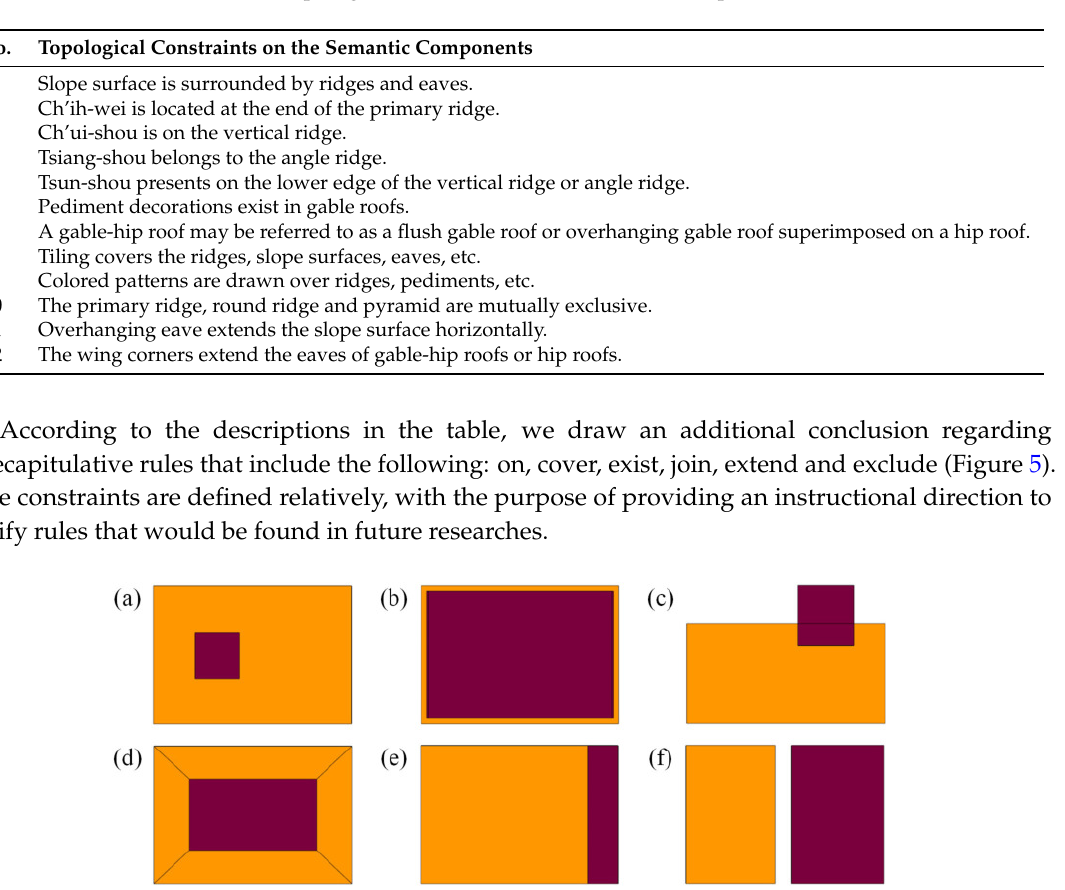
Table 2. Topological constraints on the semantic components.